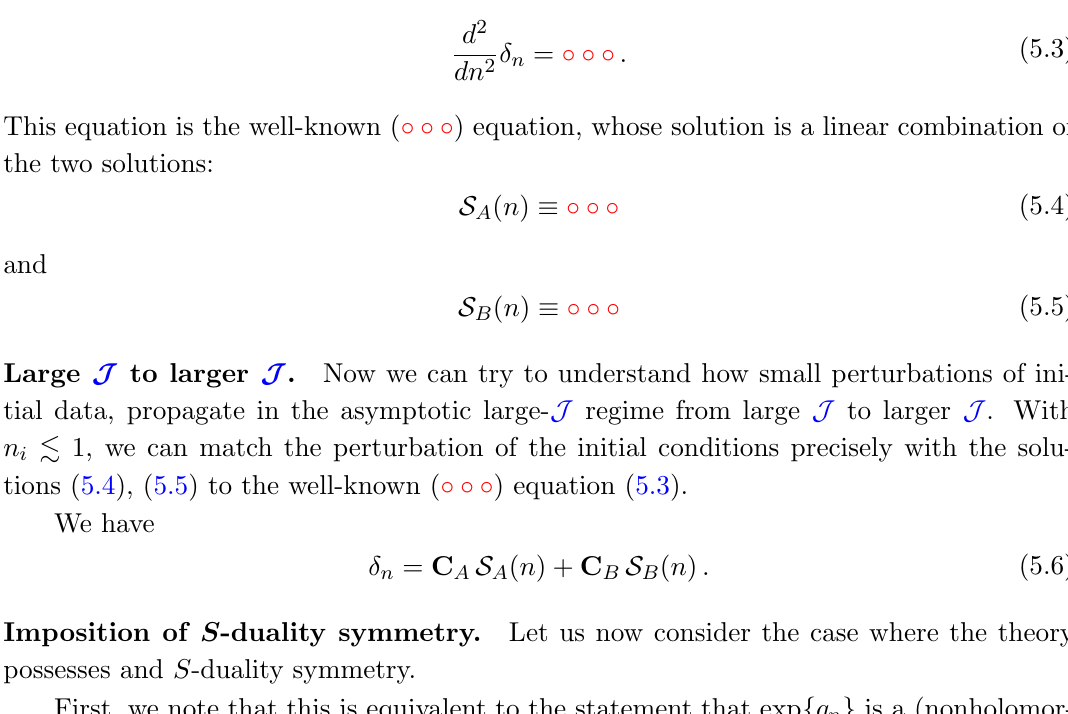
Figure 3 . Second di(cid:11)erence in n for tinuous lines) as function of Im (cid:28) at (cid:12)xed values of n . The exponential term seems to account for most of the discrepancy at small values of n (compare with (cid:12)gure 1).